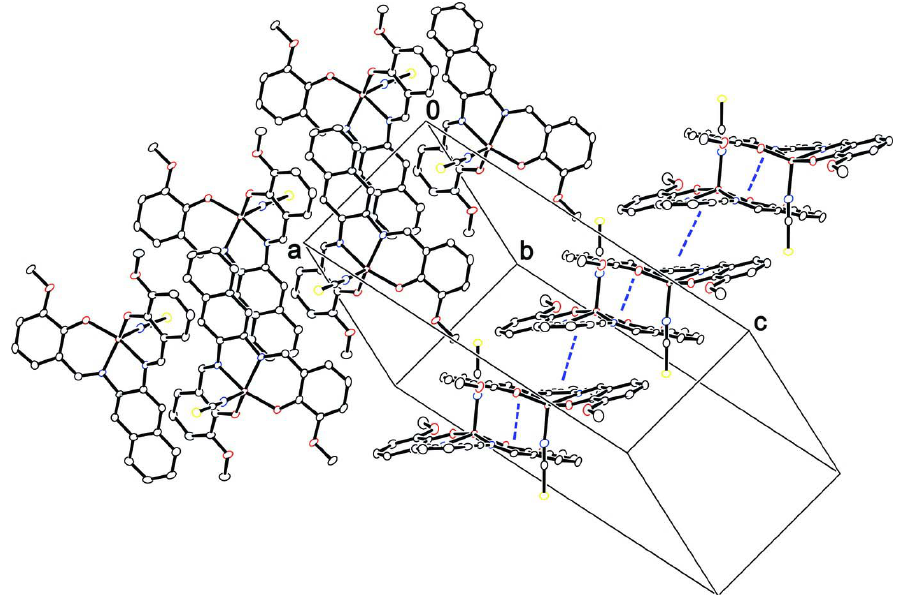
A view of crystal packing of the title complex. The π - π interactions are indicated with dashed lines. For clarity, H atoms are not